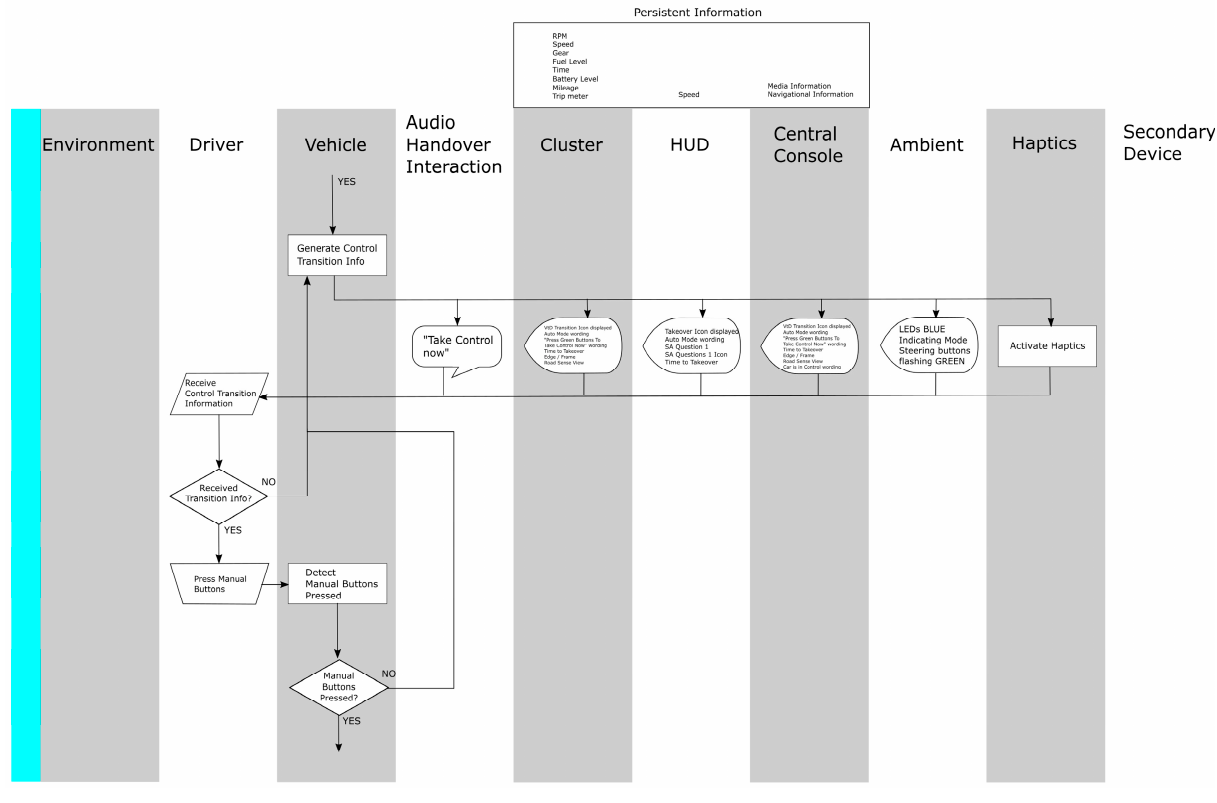
Figure 4. Human driver requested to take control of driving inputs.